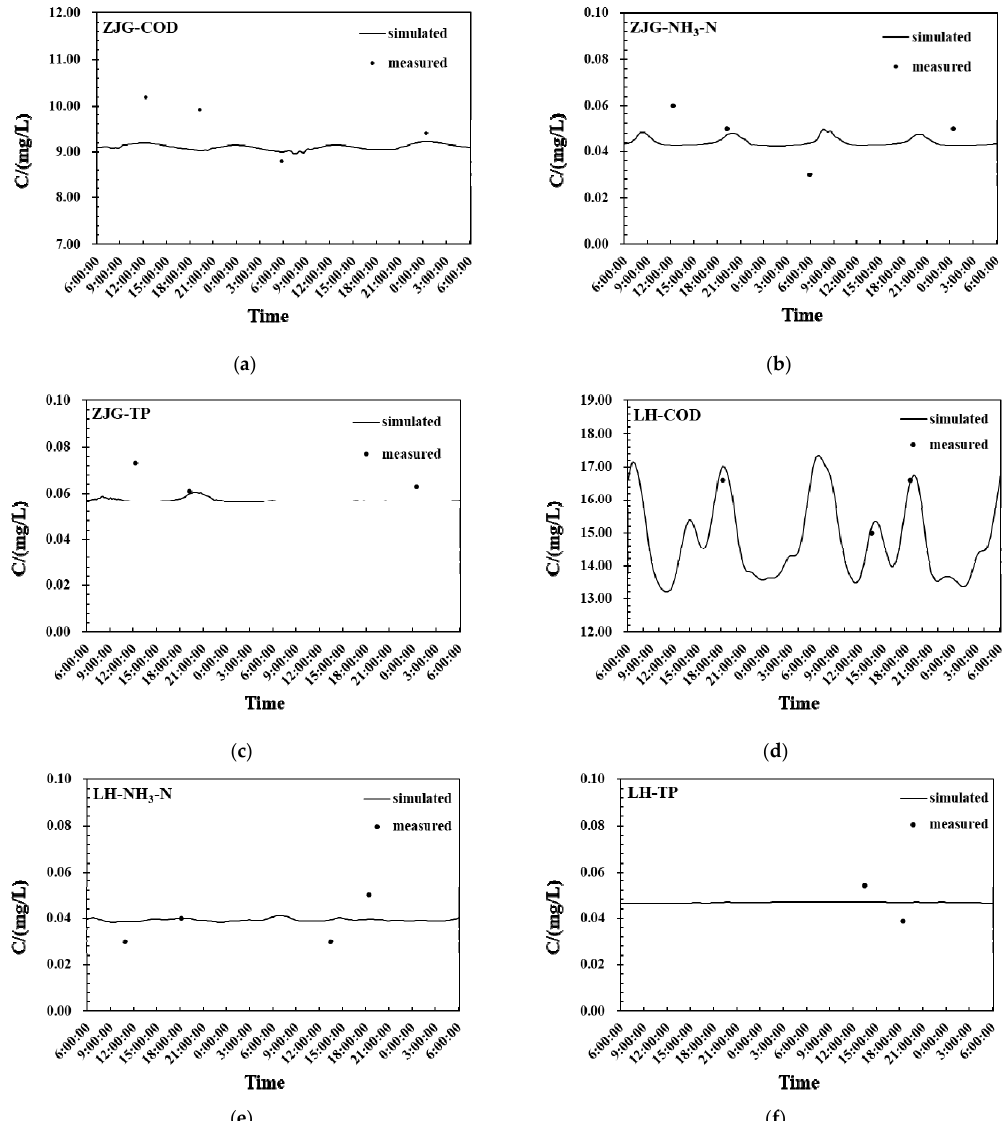
Figure 4. Calibration and validation for water quality: ( a ) Zhangjiagang (ZJG)-chemical oxygen demand (COD); ( b ) ZJG-ammonia nitrogen (NH 3 -N); ( c) ZJG-total phosphorus (TP); ( d ) Liuhe (LH)-COD; ( e ) LH-NH 3 -N; ( f ) LH-TP.